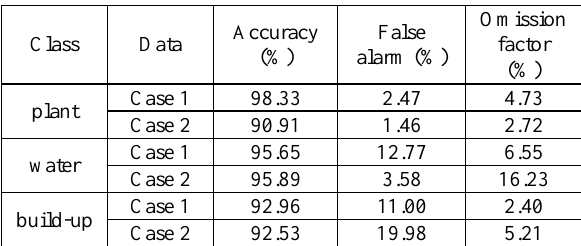
Table 5 Accuracy of Change